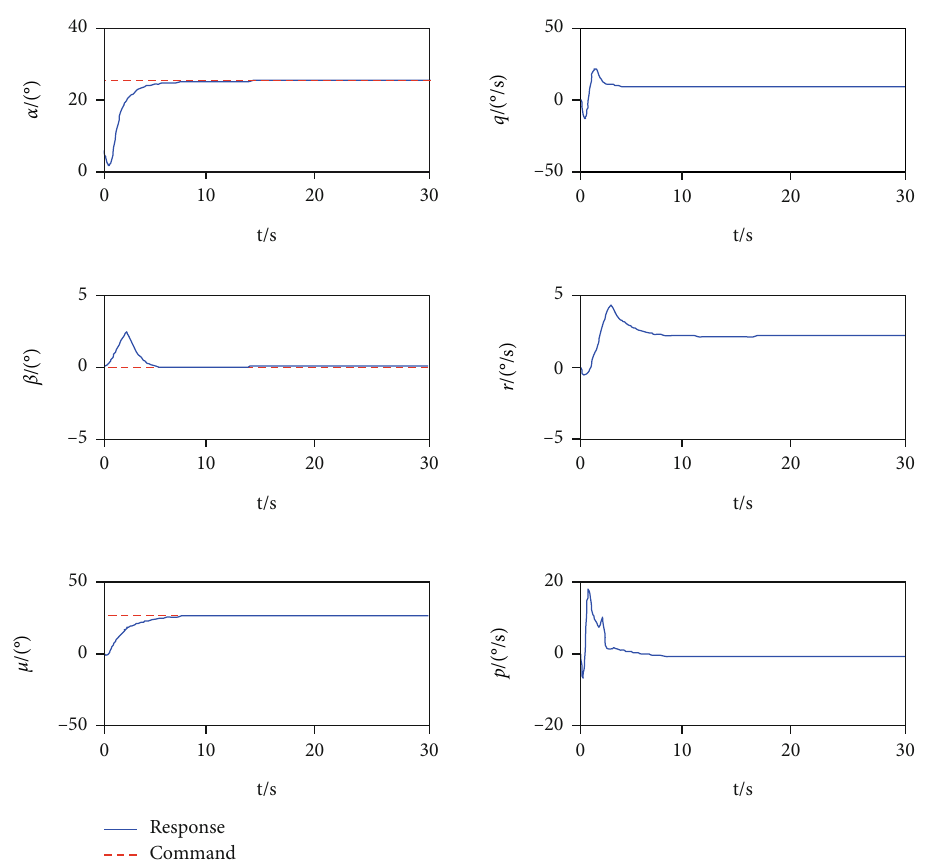
Figure 6: The de fl ection angle of surfaces against fault mode 2. The remaining surfaces also compensate for the loss forces and torques caused by the loosely fl oating actuator attached to rudder.